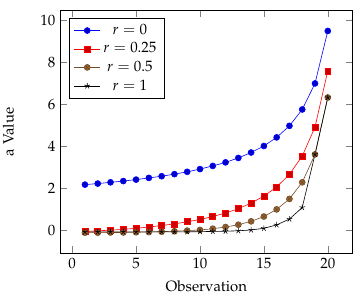
for n = 20 observations based on a uniform k = 1